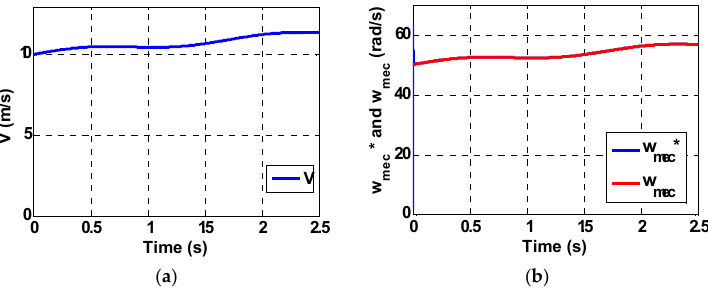
Figure 3. Simulation results of ( a ) applied wind speed profile; and ( b ) the mechanical speed ω mec and its reference ω mec * outputs of MPPT method of the wind turbine system driven IG.